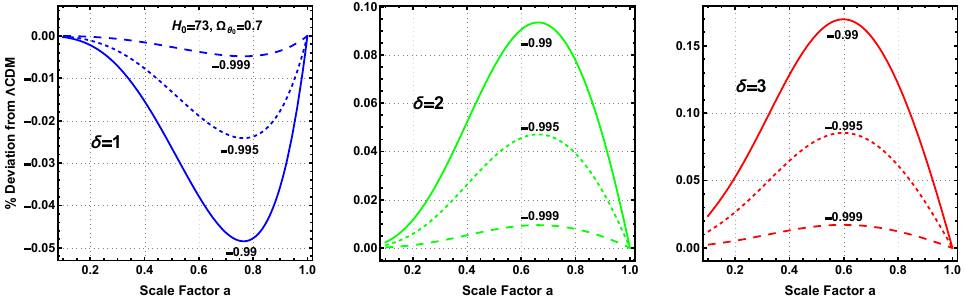
Figure 8. The percentage deviation from Λ CDM for the HI Hubble parameter. The negative numbers at the peaks and valleys in each panel are the values of w 0